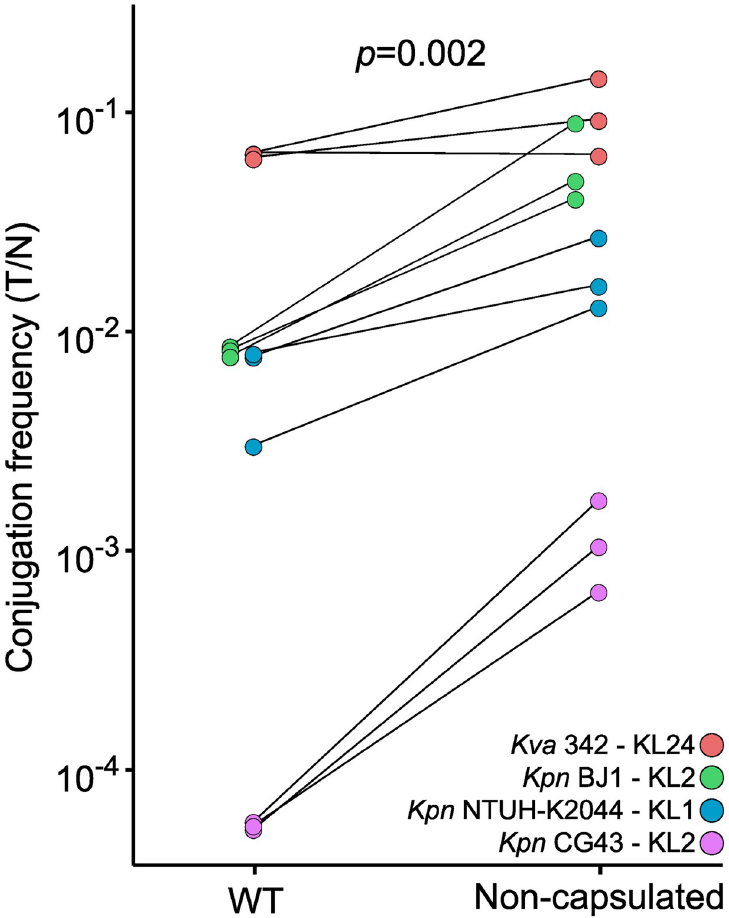
Fig 6. Capsules negatively impact conjugation. Conjugation frequency of WT and their associated non-capsulated ( Δ wcaJ ) mutants. The conjugation efficiency (T/N, see “Conjugation assay”) is represented on a log scale. Each pair of points represents a biological replicate. Strains and their capsule locus type are listed in the order in which they appear from the top to the bottom of the plot. The p -value for the paired Wilcoxon test is displayed (https://doi.org/10.6084/ m9.figshare.14673168). Kpn, Klebsiella pneumoniae ; Kva, Klebsiella variicola; CG, clonal group; WT, wild type.